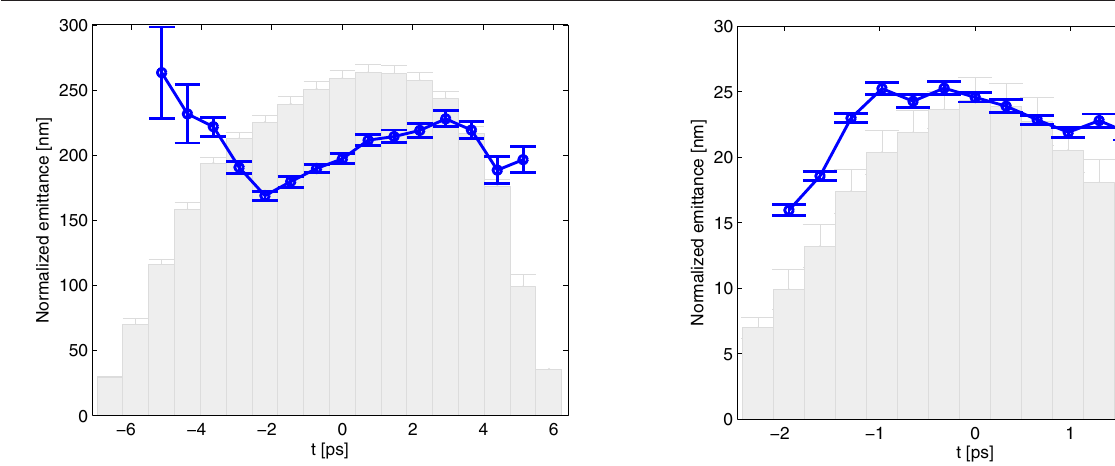
FIG. 12. Same as Fig. 9 for a bunch charge of about 30